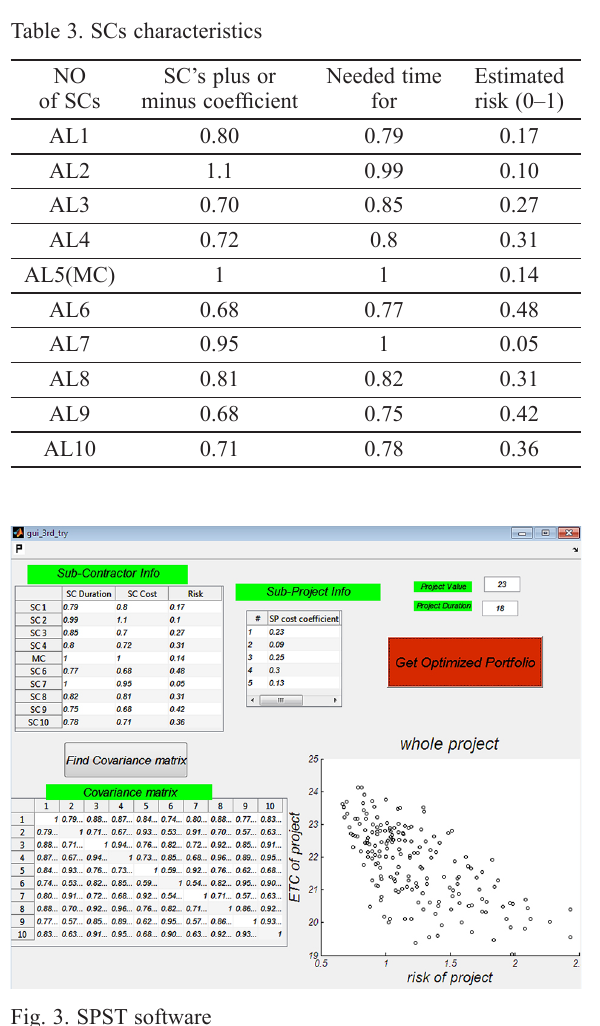
Fig. 3. SPST software